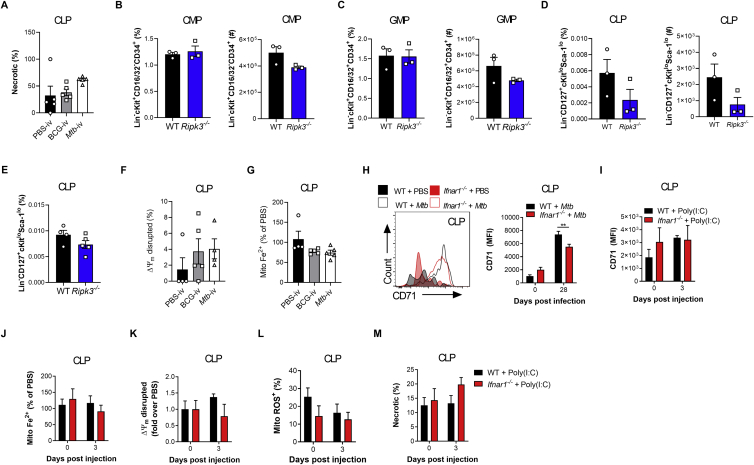
The IFN-I/Iron Axis Regulates Cell Death of Myeloid Progenitors, Related to Figure 5Frequency of necrotic (NucSpot+ AnnexinV-) CLP (A) in the BM of BCG-iv and Mtb-iv infected mice at day 7. (B-D) Frequency among single viable BM cells (left panels) and total cell counts (right panels) of CMP (B), GMP (C), CLP (D) of naive WT and Ripk3−/− mice. (E) Frequency among BM cells of CLP in WT and Ripk3−/−Mtb-iv infected mice at day 7. (F) Frequency of CLP with disrupted mitochondria in the BM of BCG-iv and Mtb-iv infected mice at day 7. (G) Relative levels of mitochondrial iron (Fe2+) in CLP of BCG-iv and Mtb-iv infected mice at day 7. (H) Representative histogram of expression of CD71 (left panel) and quantification of CD71 expression (right panel) on CLPs in the BM of Mtb-iv infected WT and Ifnar1−/− mice at day 28. (I) Expression of CD71 on CLPs in the BM of WT and Poly (I:C)-treated WT and Ifnar1−/− mice. (J) Relative proportion of mitochondrial iron dye (Fe2+) in the CLP of Poly (I:C)-treated WT and Ifnar1−/− mice. Frequency of CLPs with a disrupted mitochondrial potential (K), high mitochondrial ROS (L), or those that are necrotic (M). Differences were assessed via One-way ANOVA followed by Tukey’s Multiple Comparison Test (A; F-G), Two-tailed Student’s T-Test (B-E), Two-way ANOVA followed by Sidak’s Multiple Comparisons Test (H-M).